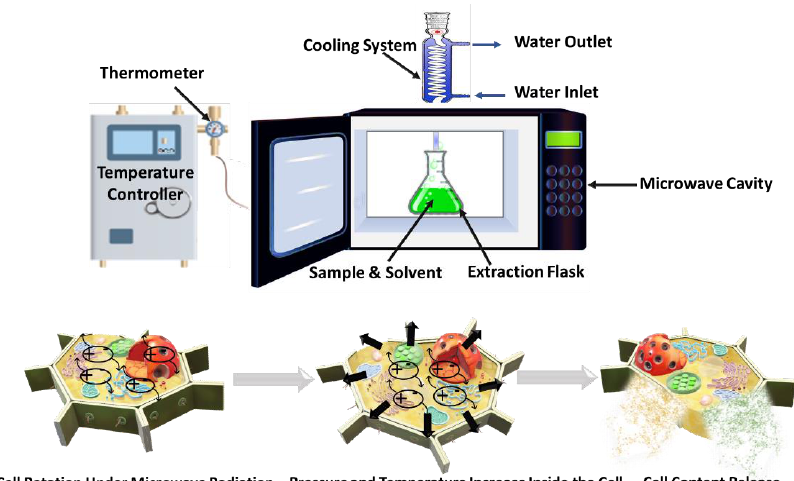
Figure 8. Schematic of microwave technology and its mechanism. Lycopene and beta-carotene, the main polyphenols in tomato wastes, are very